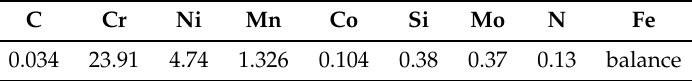
Table 1. Chemical composition of X2CrNiN23-4 in weight %.